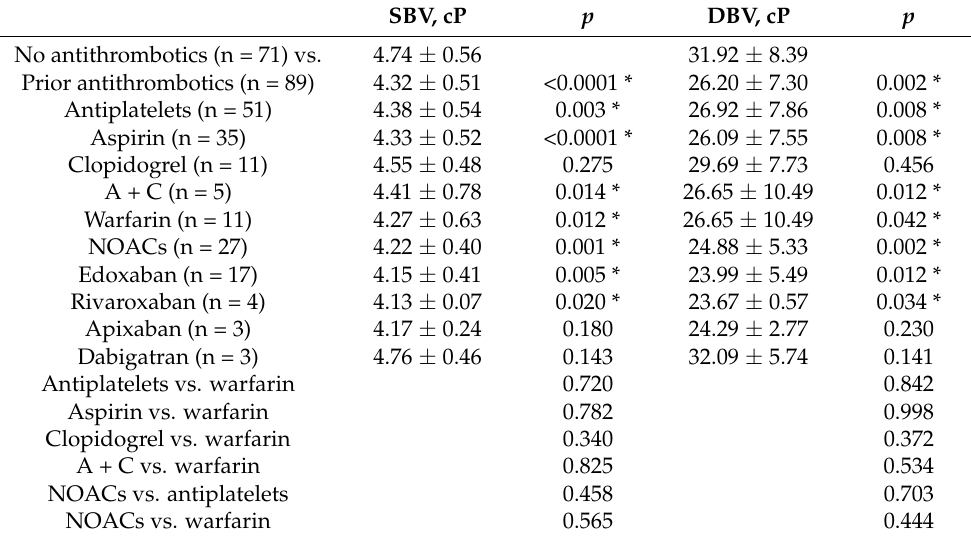
Table 2. Differences in blood viscosity according to the type of prior used antithrombotic agents. SBV, cP p DBV, cP p No antithrombotics (n = 71)